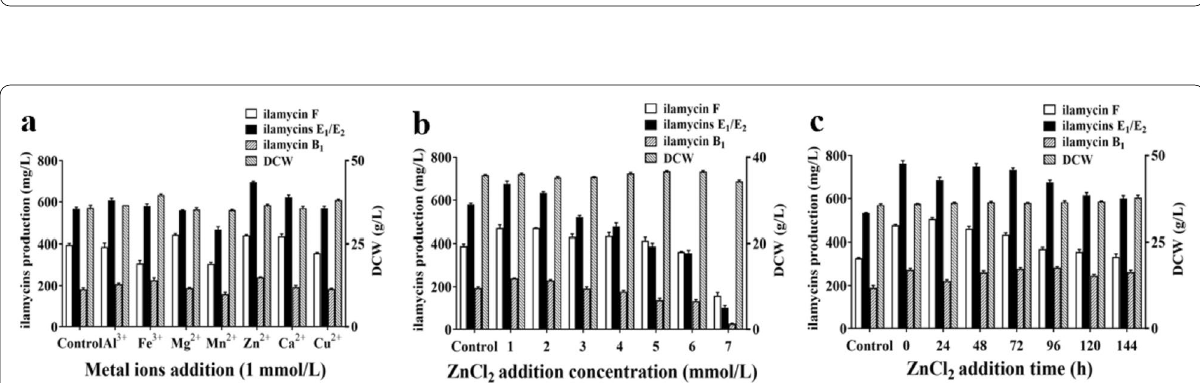
Fig. 4 Effect of initial pH value ( a ), temperature ( b ), inoculation amount ( c ), inoculation time ( d ), flask shape ( e ), volume ( f ), rotational speed ( g ), and culture time ( h ) on DCW and ilamycins production